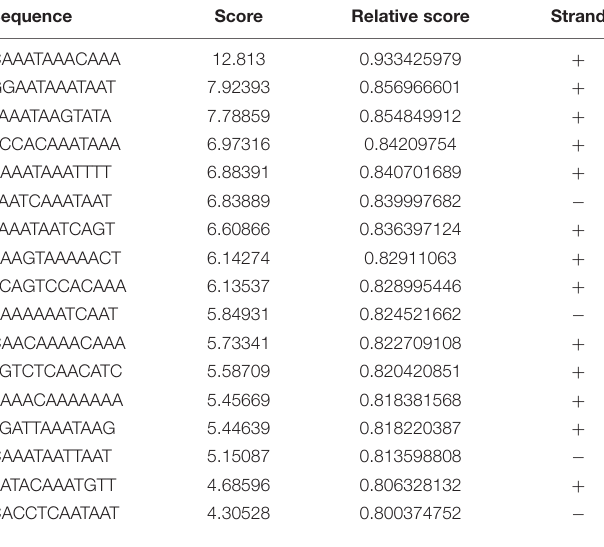
TABLE 1 | 17 potential FEBs predicted by JASPAR, whose relative scores are more than 0.8, distribute from − 456 to − 2000 bp upstream of human FOXC2 mRNA